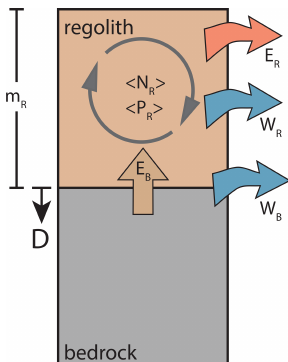
Figure 2. Conceptualization of denudation as a simple box model, where the regolith–bedrock interface lowers at the denudation rate D , by weathering ( W B ) and erosion ( E B ). CRNs are being produced within the regolith of thickness ( m R ) at an average rate of (cid:104) P R (cid:105) , resulting in an average nuclide concentration (cid:104) N R (cid:105) , while mass is leaving the regolith by regolith erosion ( E R ) and weathering ( W R